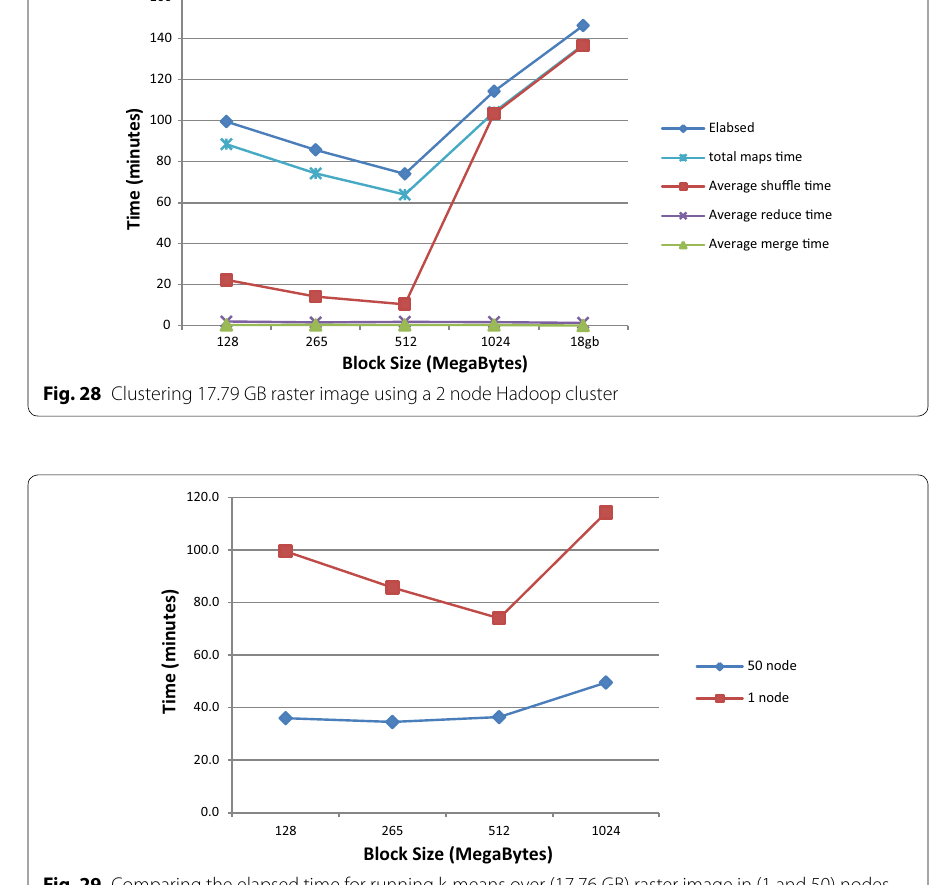
Fig. 29 Comparing the elapsed time for running k-means over (17.76 GB) raster image in (1 and 50) nodes Hadoop